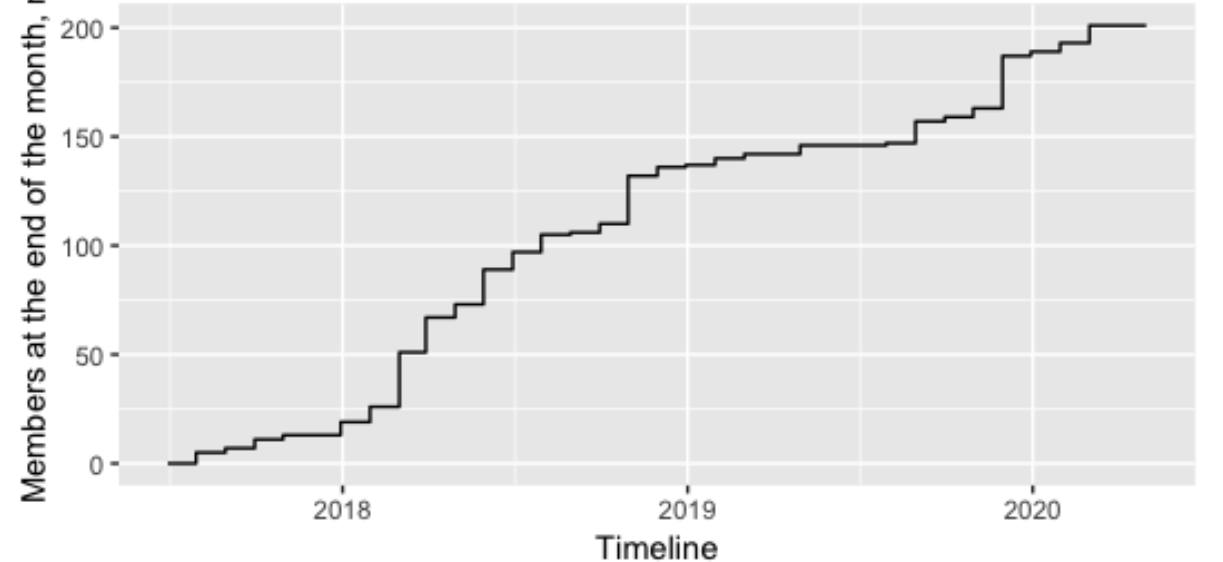
Figure 1. Number of Type 1 Diabetes Mellitus Virtual Patient Network Facebook group members from June 21, 2017, to February 4,